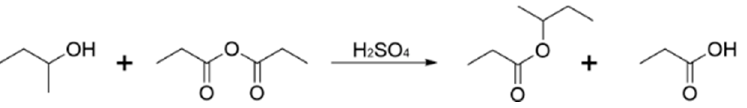
Figure 7. ( a ) TGA and ( b ) DTG data curves of n -octadecane and the